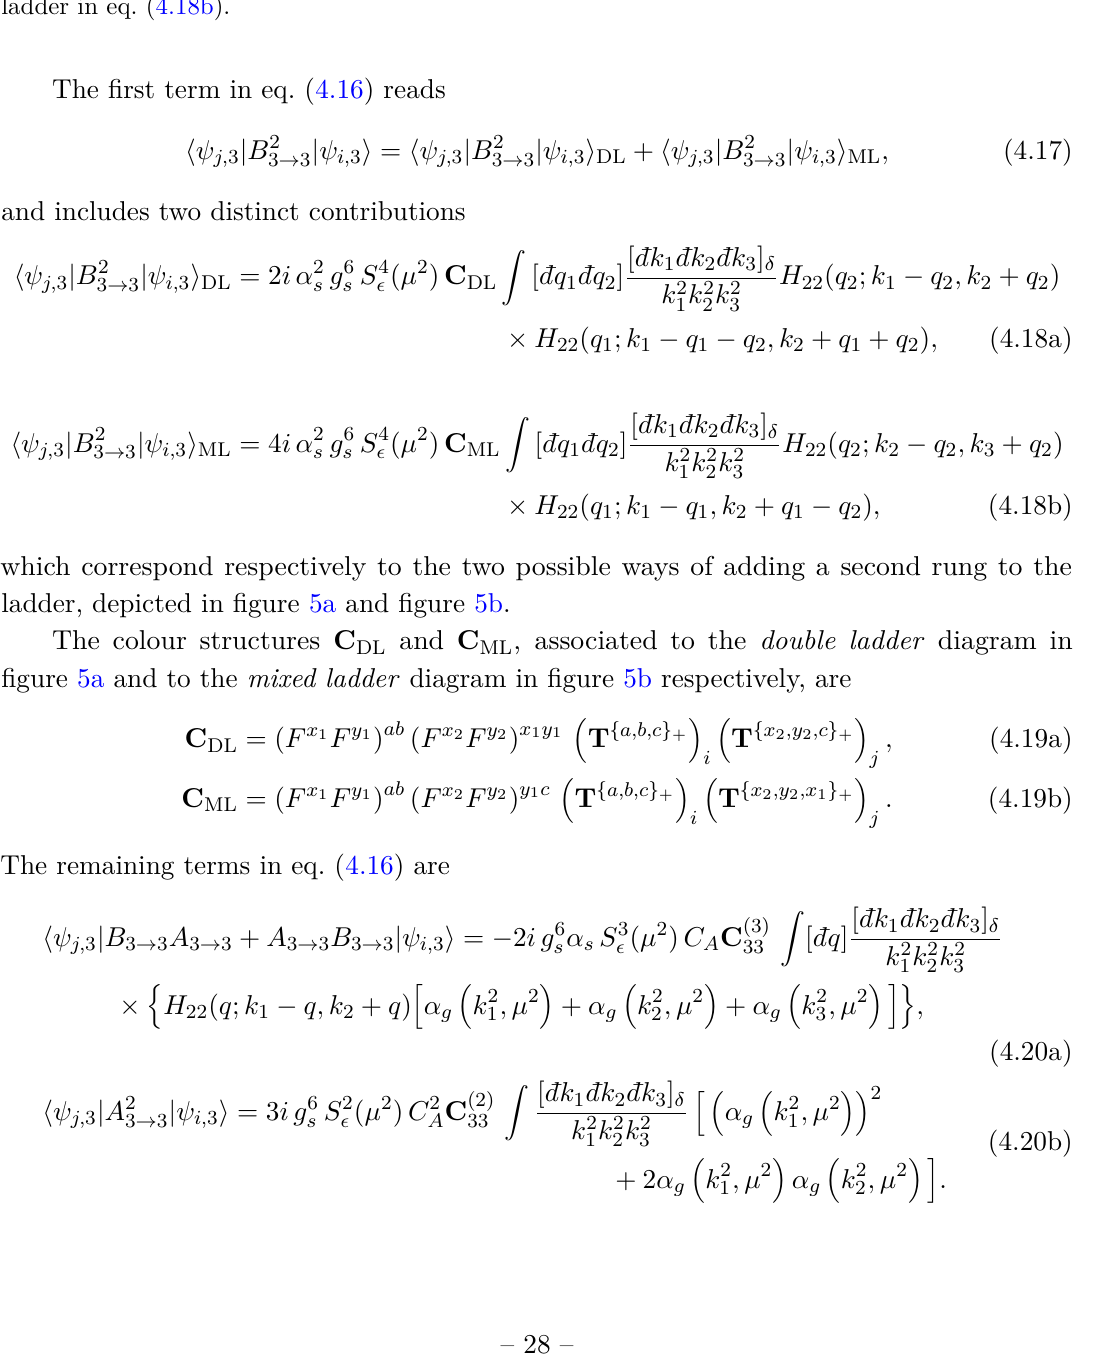
Figure 5. Diagrammatic representation of a) the double ladder in eq. (4.18a) and b) the mixed ladder in eq.